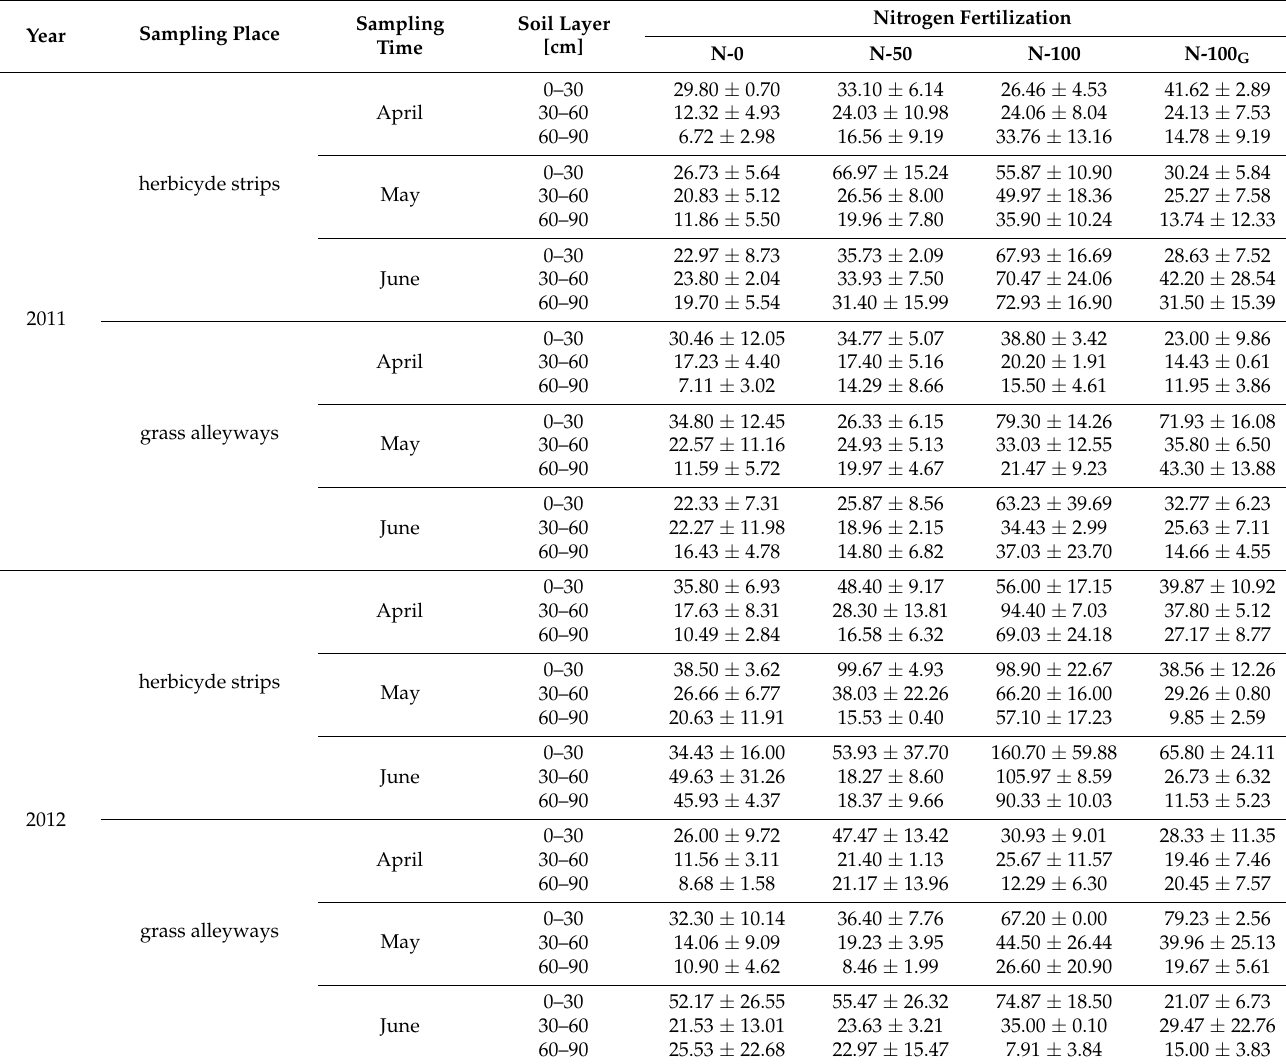
Table 2. Mineral nitrogen content in the soil (mg N · 100 g soil − 1 ; mean ± SD) in particular plots of the experiment in relation to year, sampling place, sampling time and soil